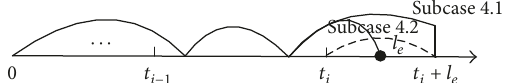
Figure 4: An immediate failure replacement with a regular ordered spare.